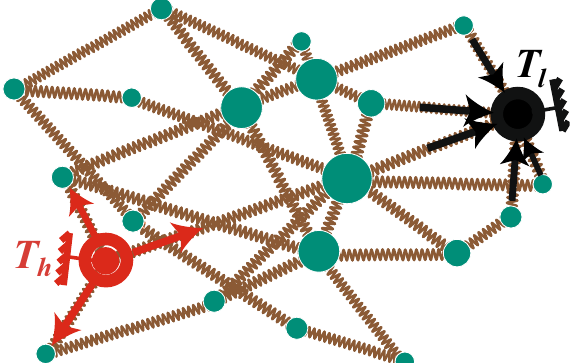
Figure 1. Schematic representation of the network model with distributed nodes masses, where the masses of nodes are correlated to the degrees of nodes by Eq. (1) with α = 1.5 , and the nodes with red and black circles are selected as the heat source nodes contacting two thermostats with high temperature T h and low temperature T l , respectively. The arrows denote the directions of heat